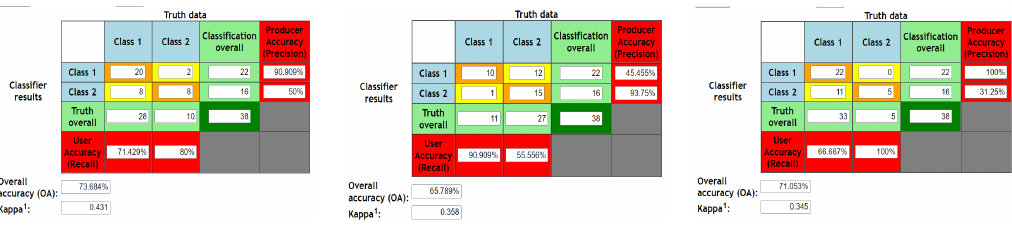
Figure 6. Confusion matrix for testing phase of 2D images for SVM, LSTM and VAE-CNN respectively.